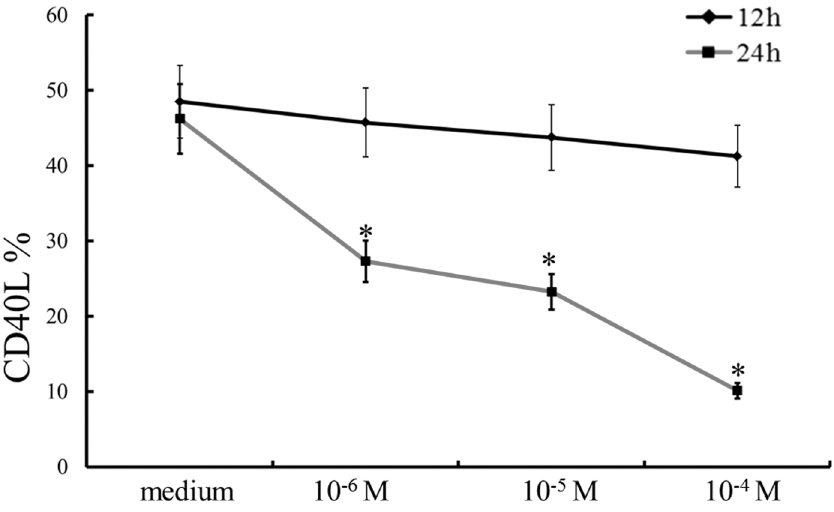
Fig 6. Recombinant PGE 2 prevention of CD40L expression on CD4+ T cells. PGE 2 significantly hinders CD40L expression on CD4 + T cells in a dose-dependent manner after 24 hours of treatment. * p < 0.05 compared to the average. Data are presented as mean ± standard error. All tests were separately carried out three times each (N = 4).